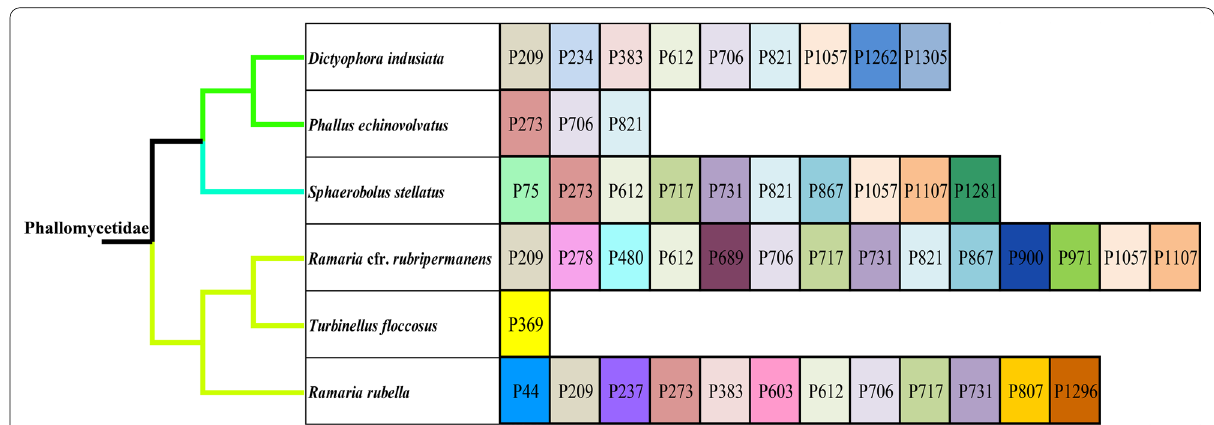
Fig. 7 Position class (Pcl) information of cox1 genes in the 6 Phallomycetidae species. Introns in cox1 genes of the 6 Phallomycetidae mitogenomes were classified into different position classes (Pcls) using the cox1 gene of Ganoderma calidophilum as the reference. Each Pcl was constituted by introns inserted at the same position of corresponding cox1 gene and named according to its insertion site in the aligned corresponding reference sequence (nt). Phylogenetic positions of the 6 Phallomycetidae species were established using the Bayesian inference (BI) method and